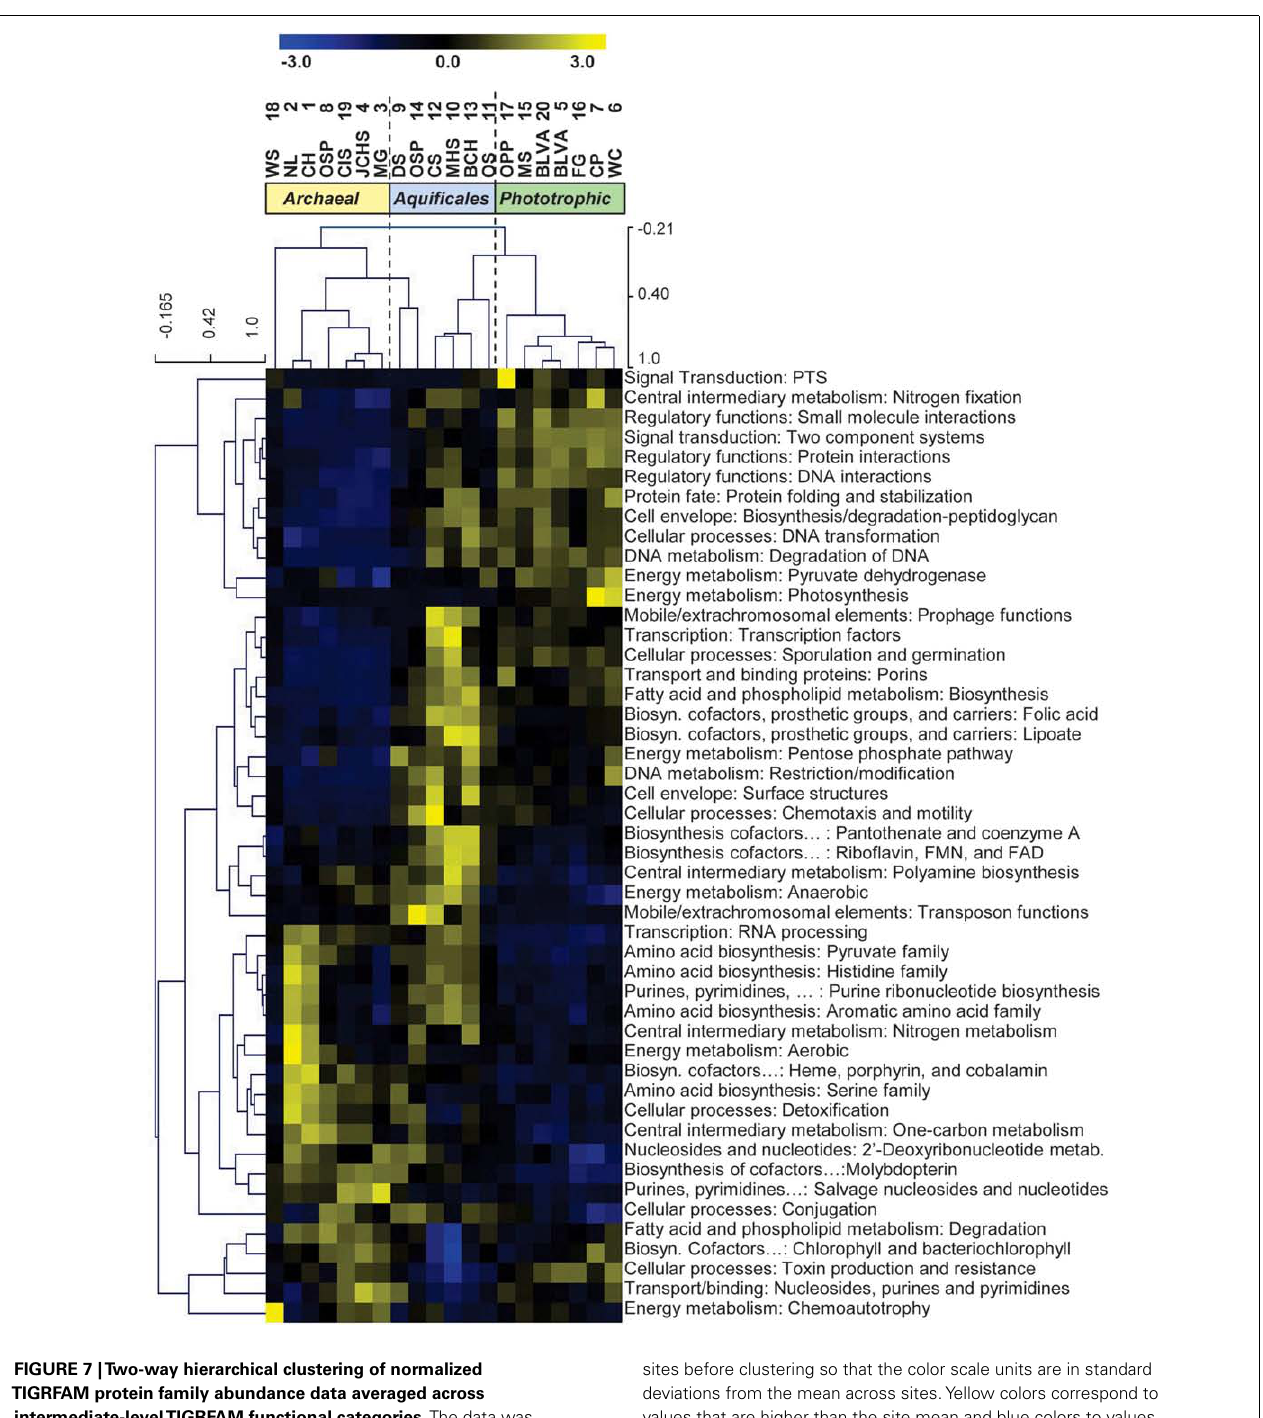
FIGURE 7 |Two-way hierarchical clustering of normalized TIGRFAM protein family abundance data averaged across intermediate-levelTIGRFAM functional categories .The data was standardized (subtract mean and divide by standard deviation) across